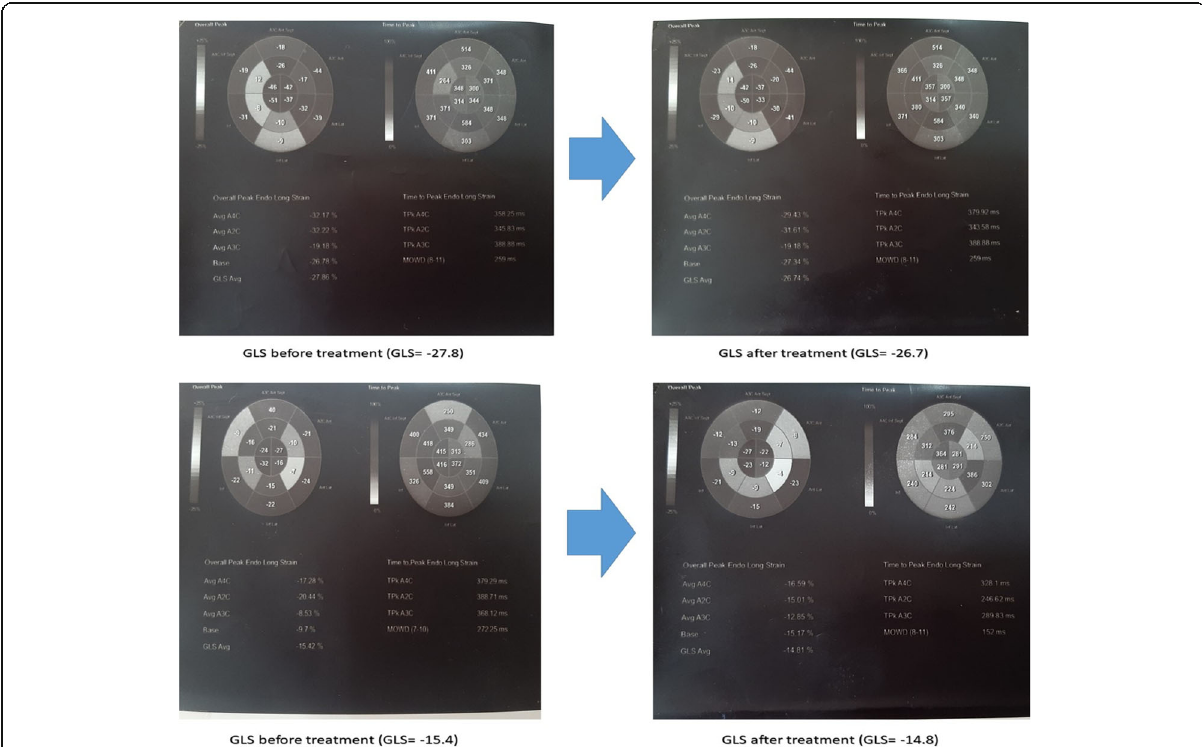
Fig. 3 Global longitudinal strain (GLS) and segmental strain analysis before and after receiving antiviral treatment in real studied cases. Upper panel images show change in changes in GLS and segmental strain analysis at case no. 15 of group I, GLS = − 27.8 before receiving antiviral treatment (left image), which worsened to − 26.7 by receiving treatment (right image). Lower panel images show change in changes in GLS and segmental strain analysis at case no. 3 of group II, GLS = − 15.4 before receiving antiviral treatment (left image), which worsened to − 14.8 by receiving treatment (right